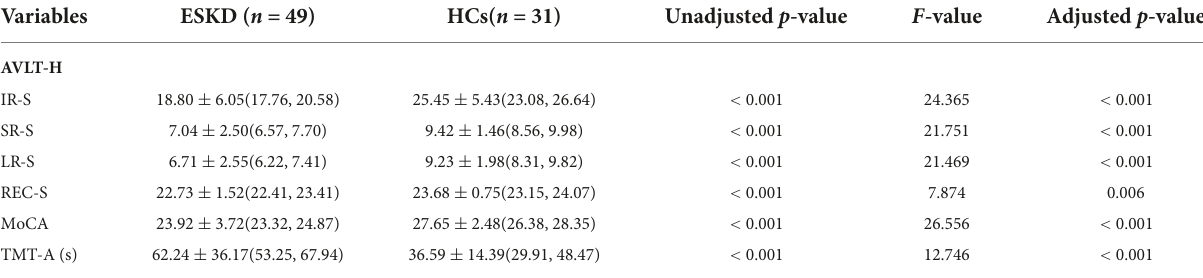
TABLE 2 Cognitive assessments in patients with ESKD and HCs.